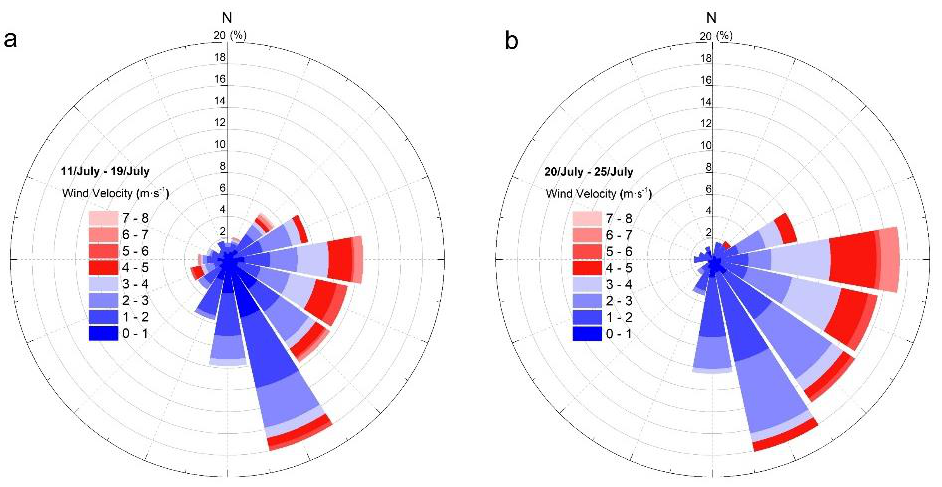
Figure 5. Colour contours of 30-min averaged ( a ) horizontal sensible heat advection ( b ) horizontal latent heat advection observed at 2 m from 11/July to 25/July in FOF.